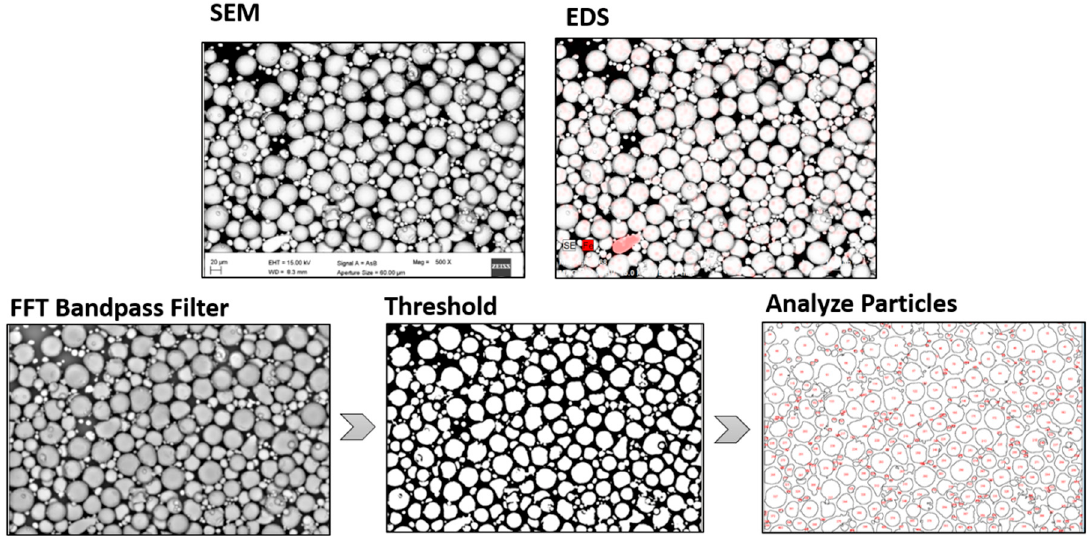
Figure 2. A graphical explanation of the procedure applied to the considered micrographs in order to highlight the cross-contamination particles and to measure them. FFT: fast Fourier transform.